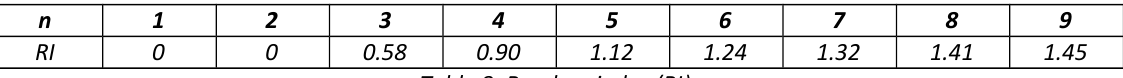
Table 8. Random index